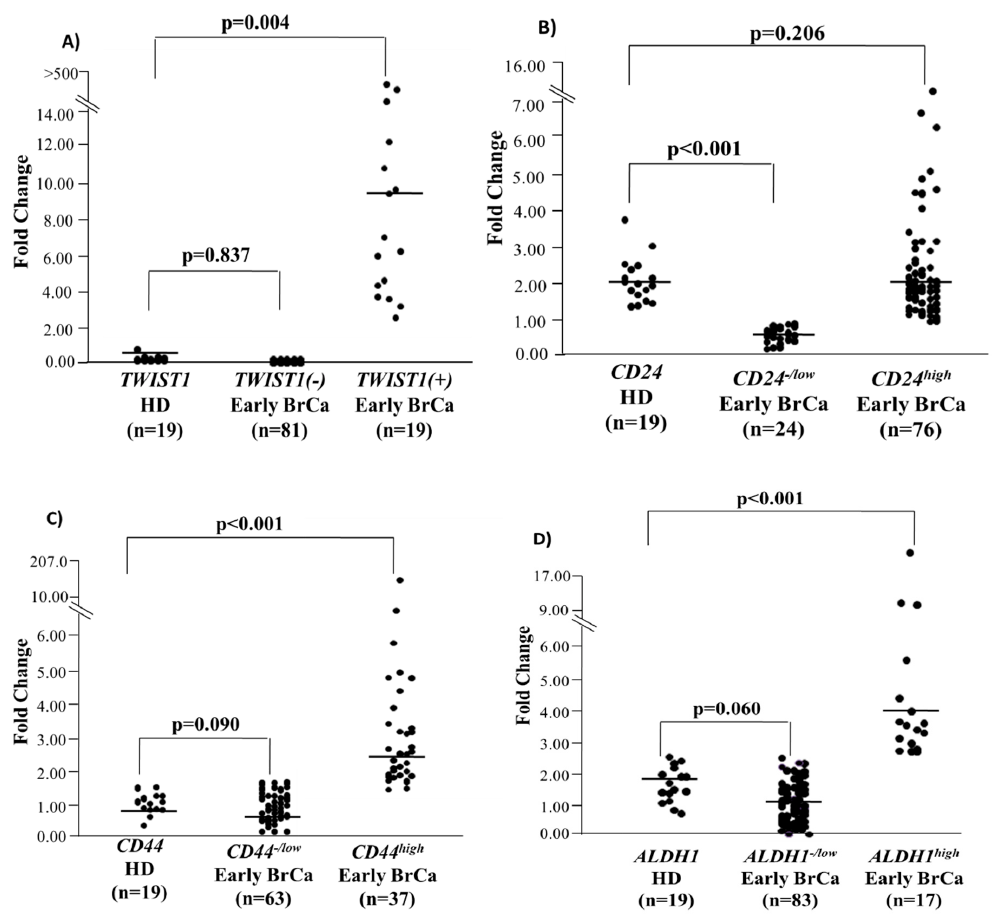
Figure 1. Relative fold change values (2 – ∆∆ Ct ) in respect to HPRT expression for: ( A ) TWIST1 ( B ) CD24 , ( C ) CD44 , ( D ) ALDH1 for early breast cancer patients ( n = 100) and (HD), ( n = 19).